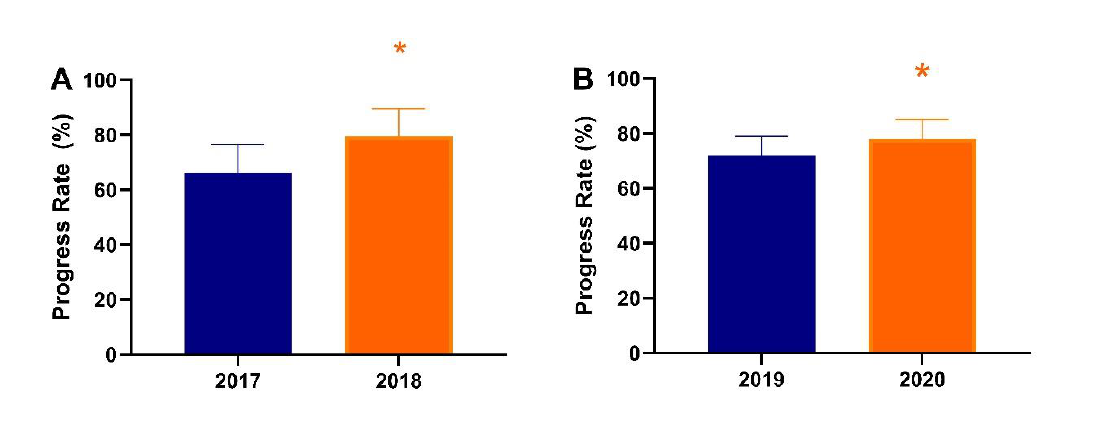
a. Significant Increase in the Average Subject Progress Rate in 2018 in the Faculty of Science, n= 25 Subjects b. In 2020, n=83 Subjects